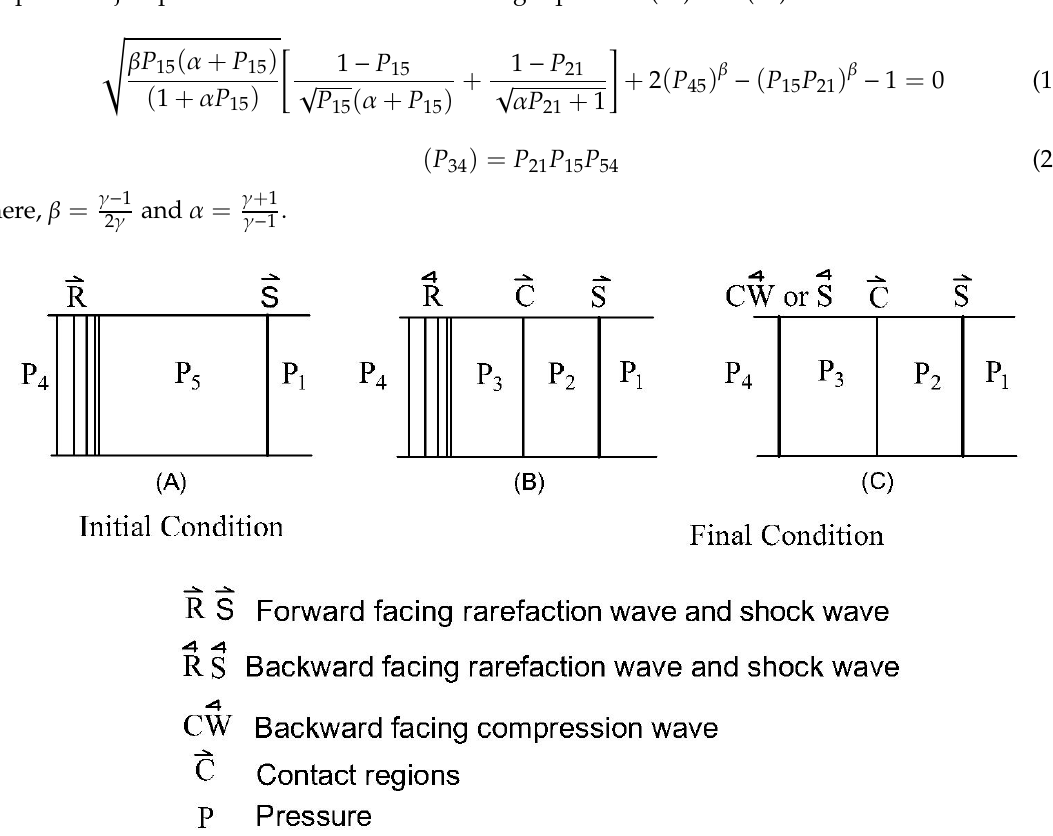
Figure 5. Overtaking of a shock wave by a weak rarefaction wave [Adopted based on a figure in Glass et al (1959)].